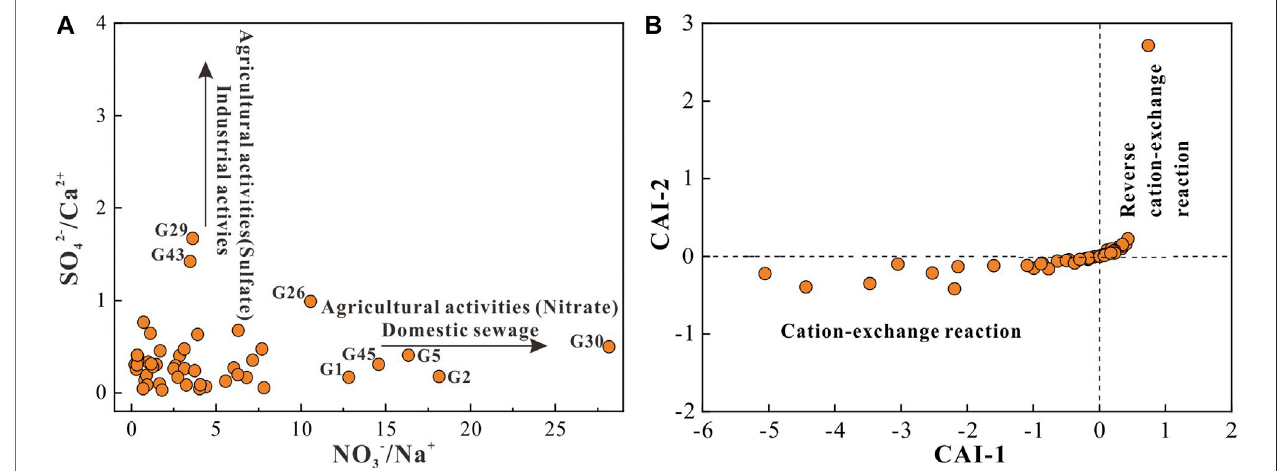
FIGURE 7 | Plots of (A) molar ratio NO 3 − /Na + versus molar ratio SO 4 2 − /Ca 2+ and (B) CAI-1 versus CAI-2 for phreatic groundwater in the study